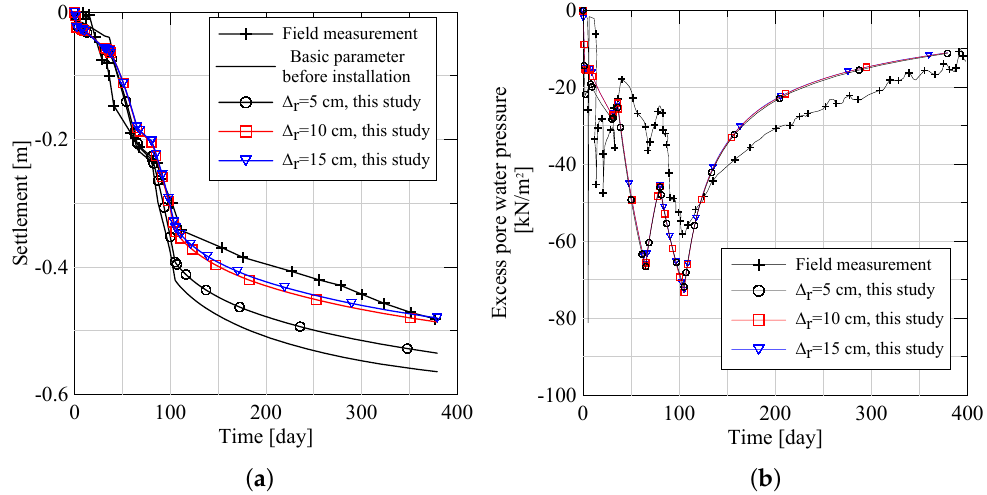
Figure 14. Comparison of the field measurement and finite element model. ( a ) settlement for different cavity expansion degrees, ( b ) excess pore pressure at 20